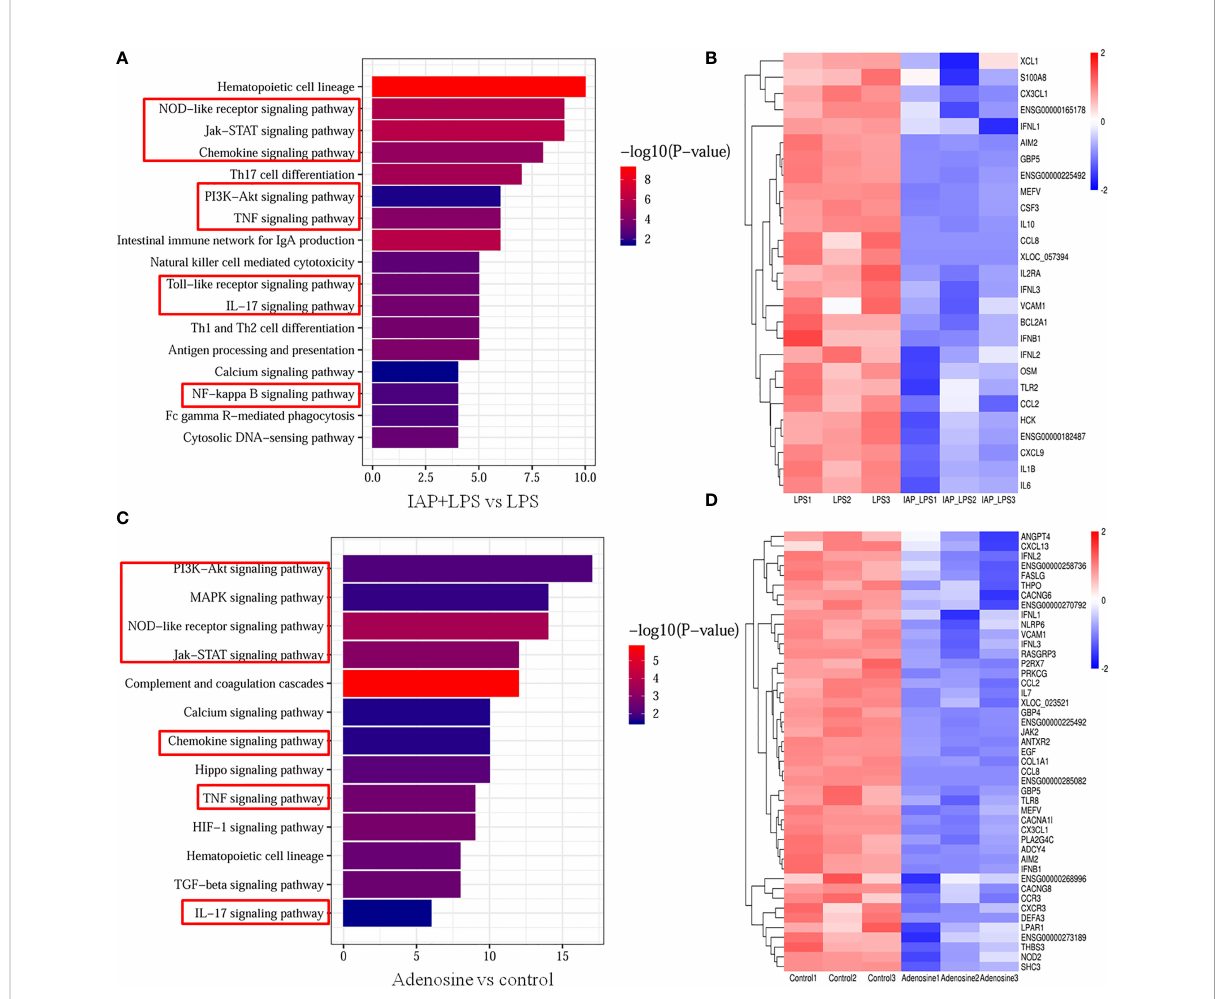
FIGURE 12 Transcriptome analysis of the anti-in fl ammatory effect of IAP in vitro . Signalling pathways related to the immune system and signal transduction KEGG enrichment of (A) IAP+LPS vs. LPS and (C) adenosine vs. control. Expression heatmap of signature genes in intestinal in fl ammation of (B) IAP+LPS vs. LPS and (D) adenosine vs.